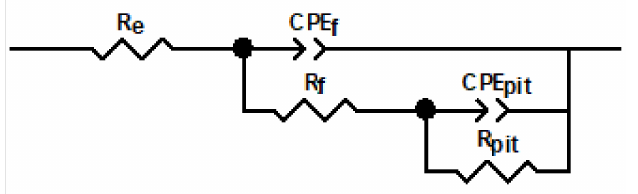
Figure 9. Electrical equivalent circuit proposed for the substrate and deposited-layer samples in NaCl water